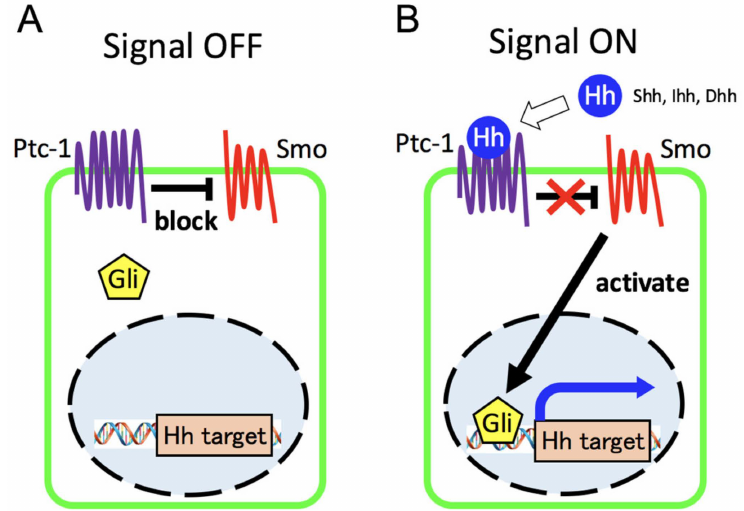
Figure 2. Overview of hedgehog signaling pathway. ( A ) In the absence of Hh ligands, Ptc-1 blocks Hh pathway activation through the repression of Smo. ( B ) Once the Hh ligand binds to Ptc-1, the repressive action to Smo is released, and Gli-mediated transcription leading to the regulation of downstream target Hh is